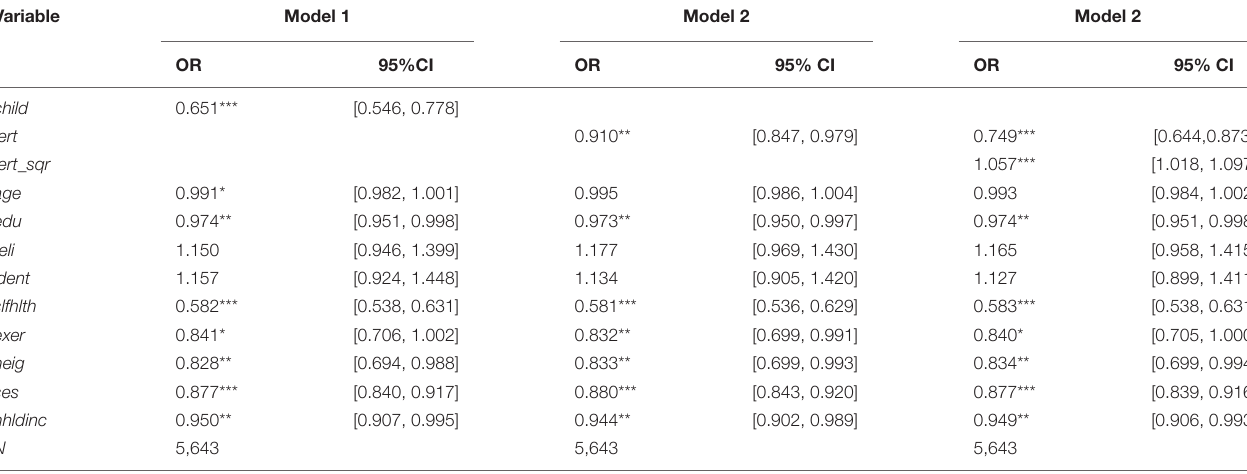
TABLE 2 | Fertility behavior and depressive symptoms among women—logistic regression.